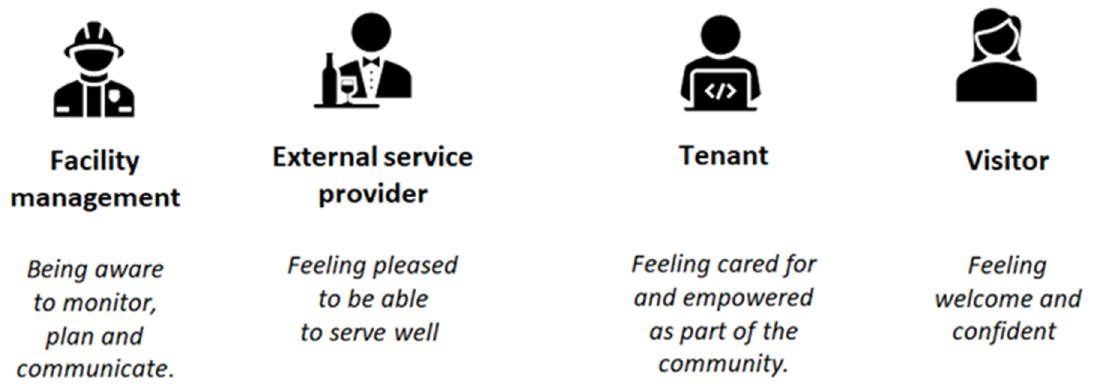
Figure 4. The UX visions for key occupant groups.